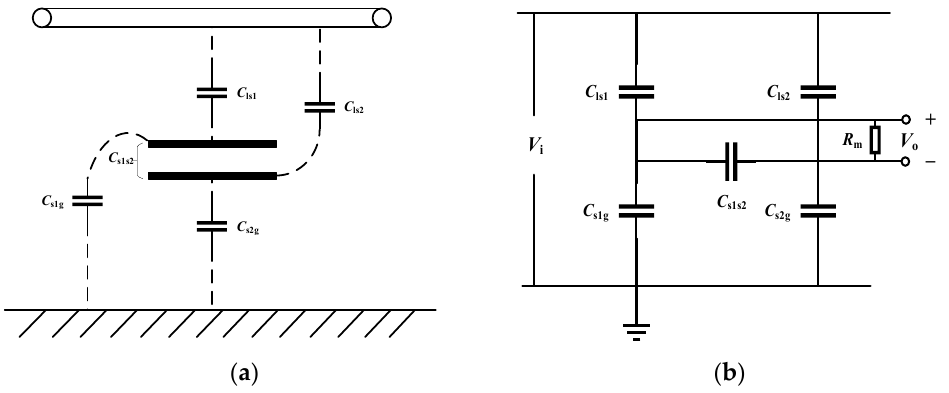
Figure 1. Five capacitance model. ( a ) Principal diagram of five capacitance; ( b ) Equivalent circuit diagram of five capacitance model.